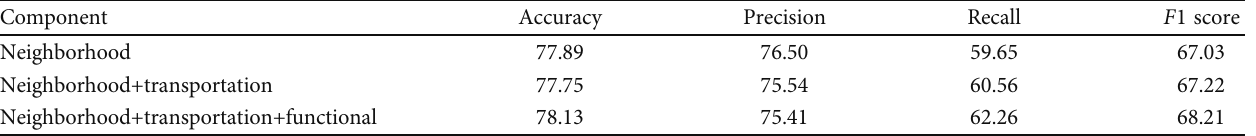
Table 3: E ff ect of adding components to the spatial correlation modeling on the performance.